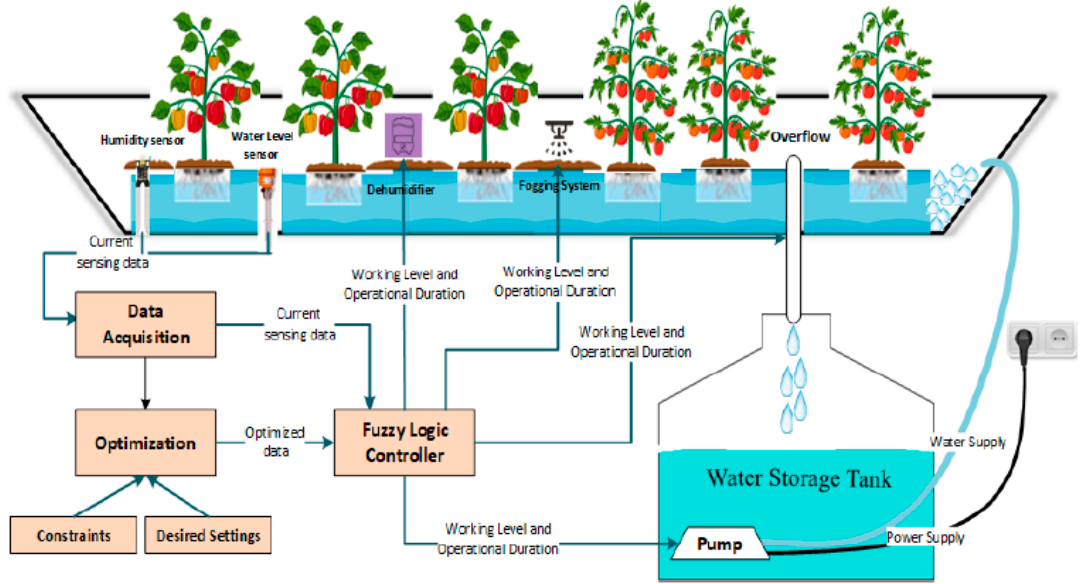
Figure 2. Hydroponics configuration with proposed optimization and control scheme.